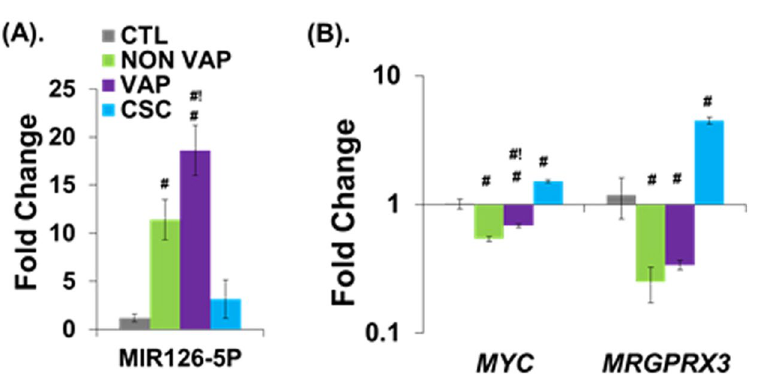
Figure 5. Validation of expression for MIR126-5P and its target mRNAs in eCig treated human lung epithelial cells. Validation of MIR126-5P induction, and suppression of its target mRNAs by eCig liquid. Shown are fold differences in expression (log scale) for each gene upon eCig exposure. ( A ) MIR126-5P is highly induced by eCig liquid, particularly following vaporization. Increased expression of MIR126-5P upon CSC treatment did not reach significance. ( B ) Two MIR126-5P–specific target genes, MYC and GPCR , display reduced expression following treatment with e-cg liquid. Increased expression of MIR126-5P following treatment with eCig liquid resulted in decreased expression of MYC (46% in NON VAP, 31% in VAP) and MRGPRX3 (75% in NON VAP, 66% in VAP), as compared to CTL cells. # p < 0.05 (MWU) (vs CTL); #! p < 0.05 (NON VAP vs VAP)